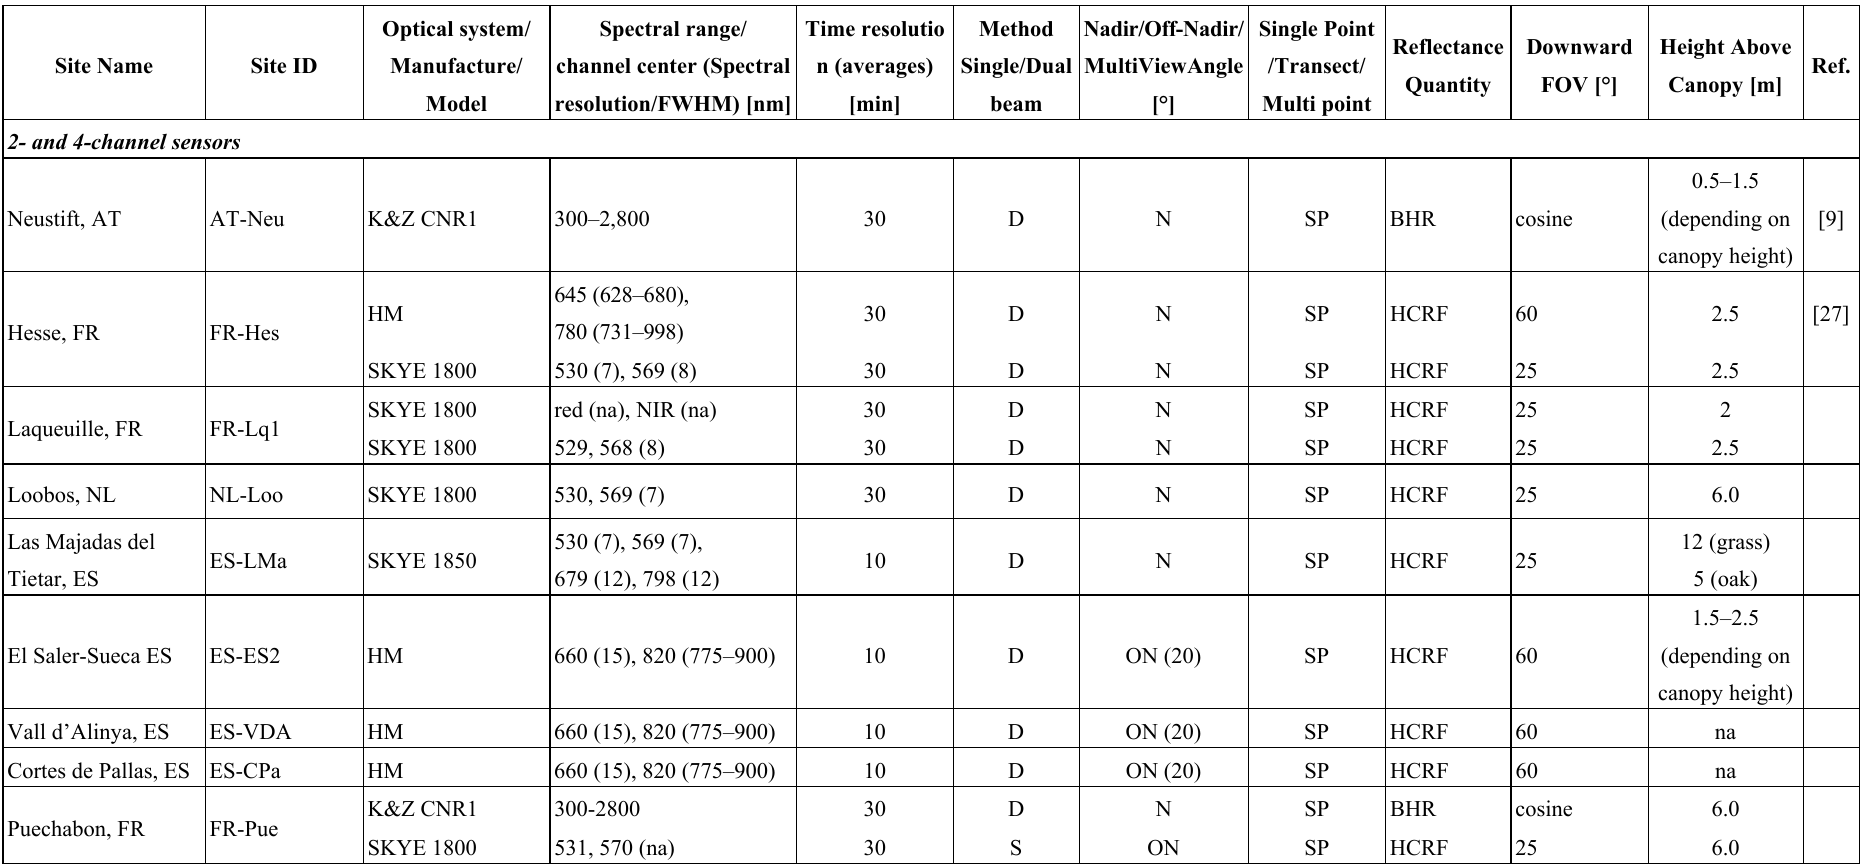
Table 1. List and principal characteristics of the automatic optical systems currently installed at European eddy flux towers. The site name, site FLUXNET ID, optical system (Manufacturer/Model), spectral range/channels (nm) and their resolution (FWHM, nm), the method used for acquisition (Single/Dual beam), the geometry of acquisition (Nadir/Off-Nadir/MultiViewAngle), the spatial sampling scheme (Single point/Transect/Multi point), the reflectance quantity (BHR, Bi-Hemispherical Reflectance factor/HCRF, Hemispherical-Conical Reflectance Factor), the downward Field of View (FOV), sensor Height Above the Canopy (m) and references, when available, are reported. K&Z stands for Kipp&Zonen. HM stands for home made. “na” stands for answer not